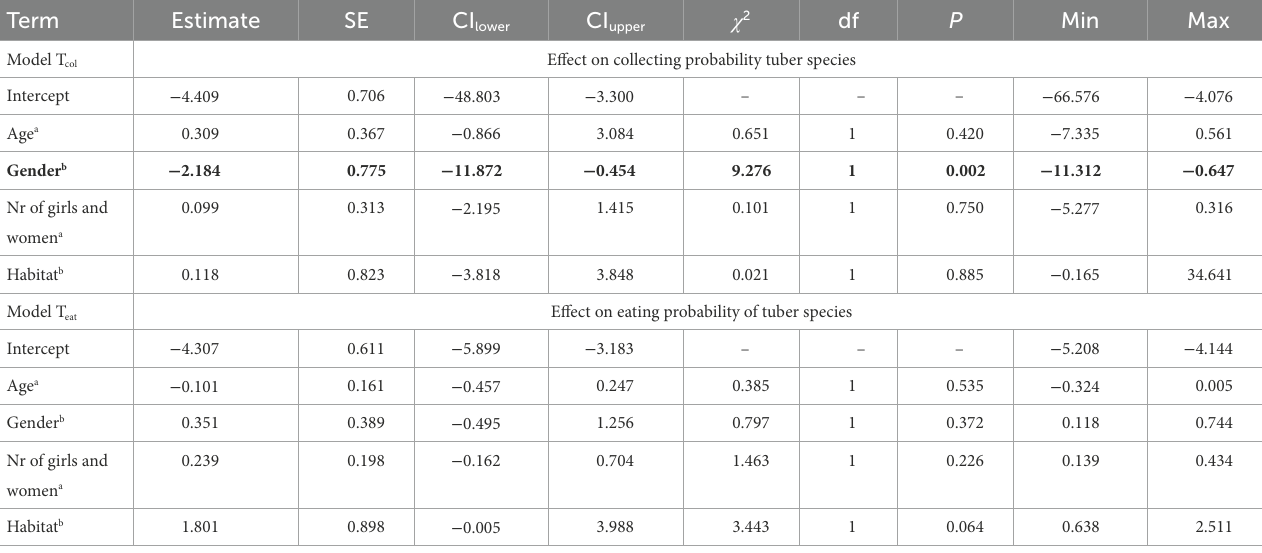
TABLE 2 Probability of collecting and eating tuber